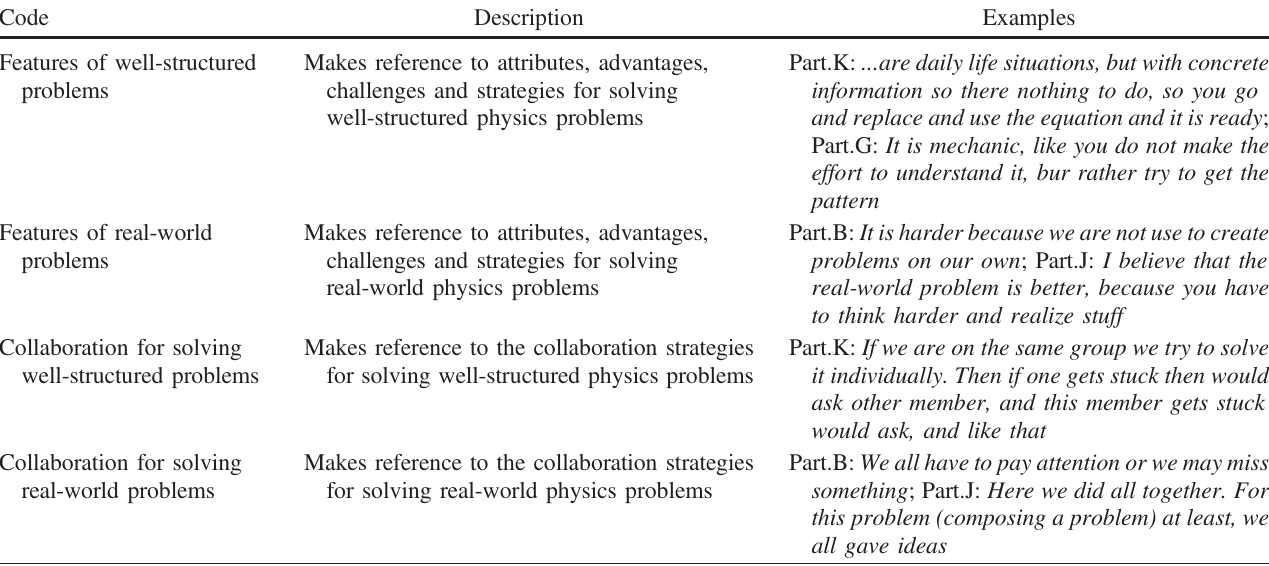
TABLE II. Code book for analysis of participants ’